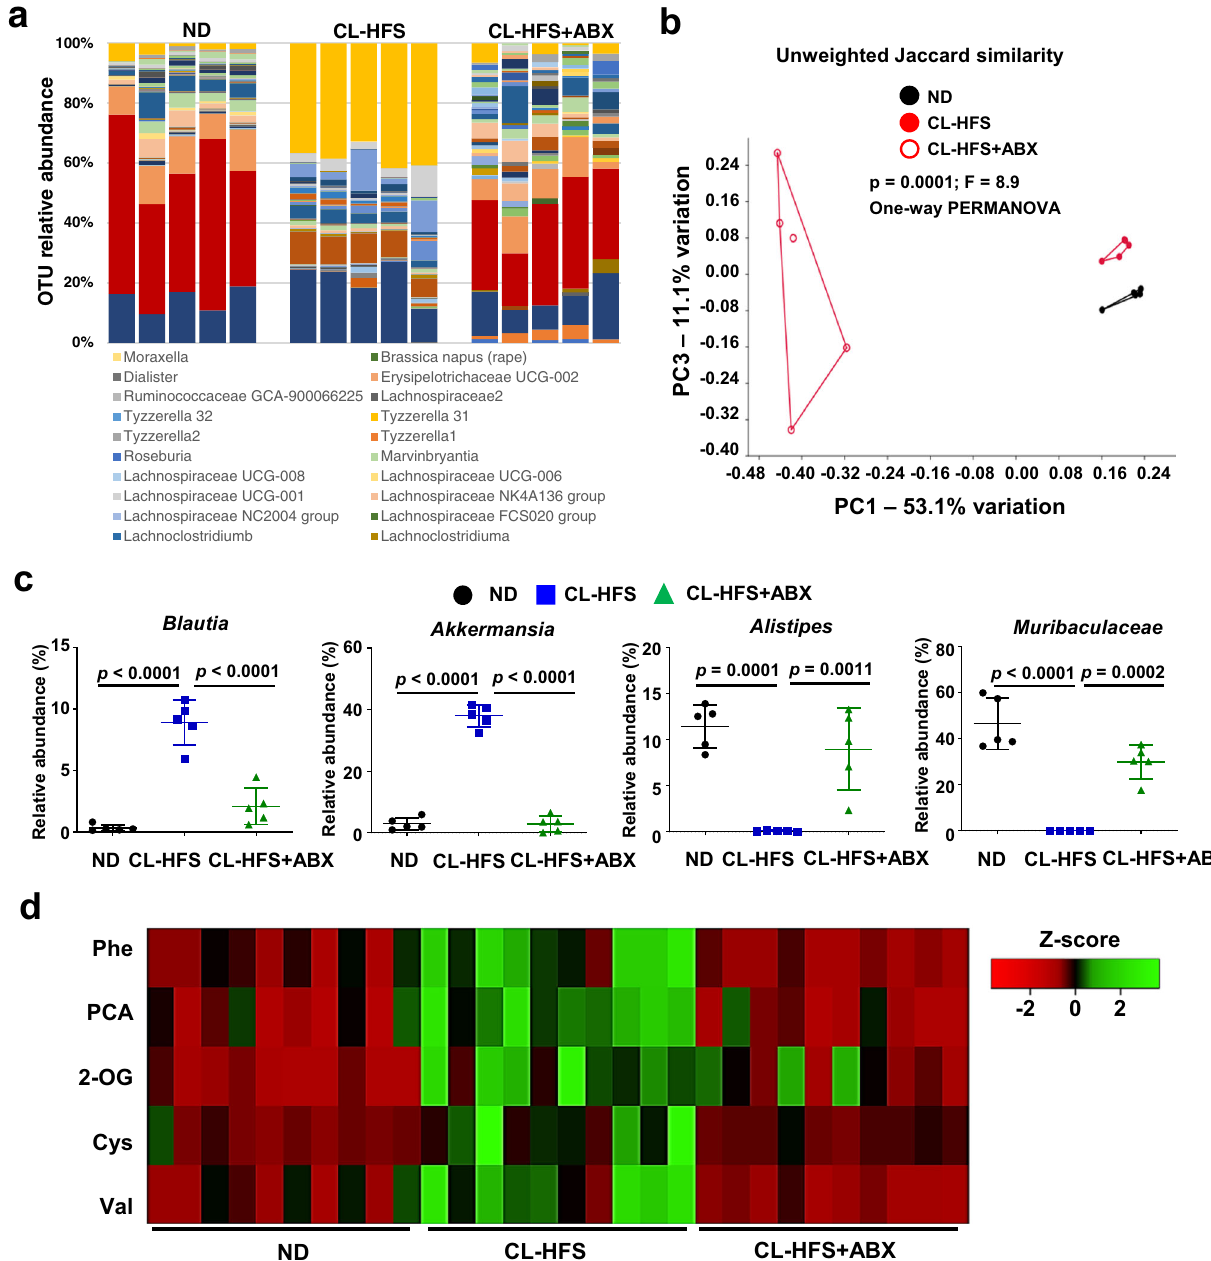
Fig. 3 | ABX treatment alters the pro fi les of gut microbiota and hepatic meta- bolites. Fecal and liver samples were collected from Fig. 2 mice, which were fed with ND orCL-HFS in the absenceor presenceof ABX for12weeks. a Effectof ABX ontherelativeabundanceofoperationaltaxonomicunit(OUT)inCL-HFS-fedmice. 16SrRNAgenesequencingoffecalsamplesidenti fi edthepro fi lesofgutmicrobiota in three groups of mice. b ABX treatment changed gut microbiota similarity. PER- MANOVA signi fi cancetest wasperformed with Principal-coordinate analysis (PCA) to de fi ne the Jaccard similarity index. c ABX induced a signi fi cant alteration in representative bacterial species. ABX treatment signi fi cantly reduced the relative abundance of Blautia and Akkermansia and increased the relative abundance of Alistipes and Muribaculaceae inthefecalsamplesofCL-HFS-fedmice. n =5,dataare